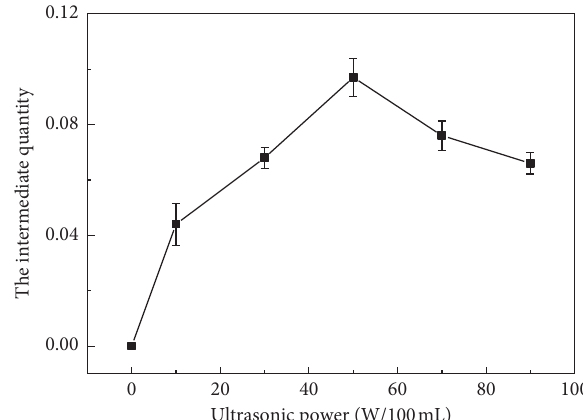
Figure 8: The effect of ultrasonic power on browning intensity.